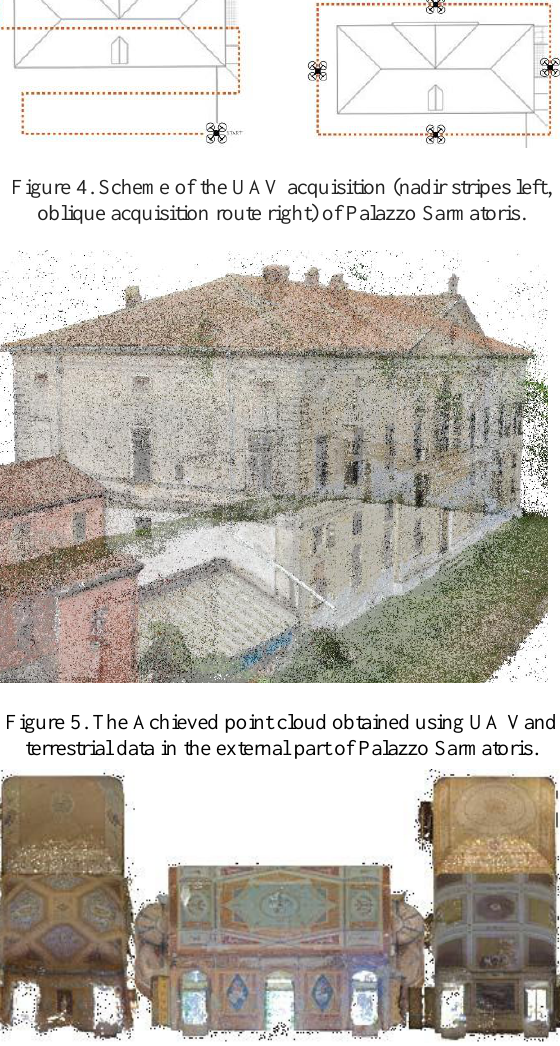
Figure 6. Point clouds of the five main room in the lower floor. of Palazzo Sarmatoris